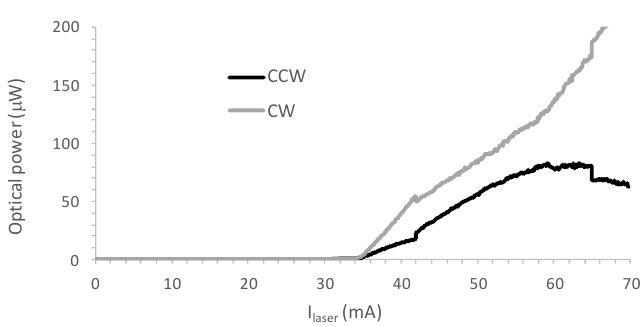
Figure 3. Output power of the two directional modes versus laser injection current while the current in the filtered optical feedback (FOF) section is equal to 0 mA.